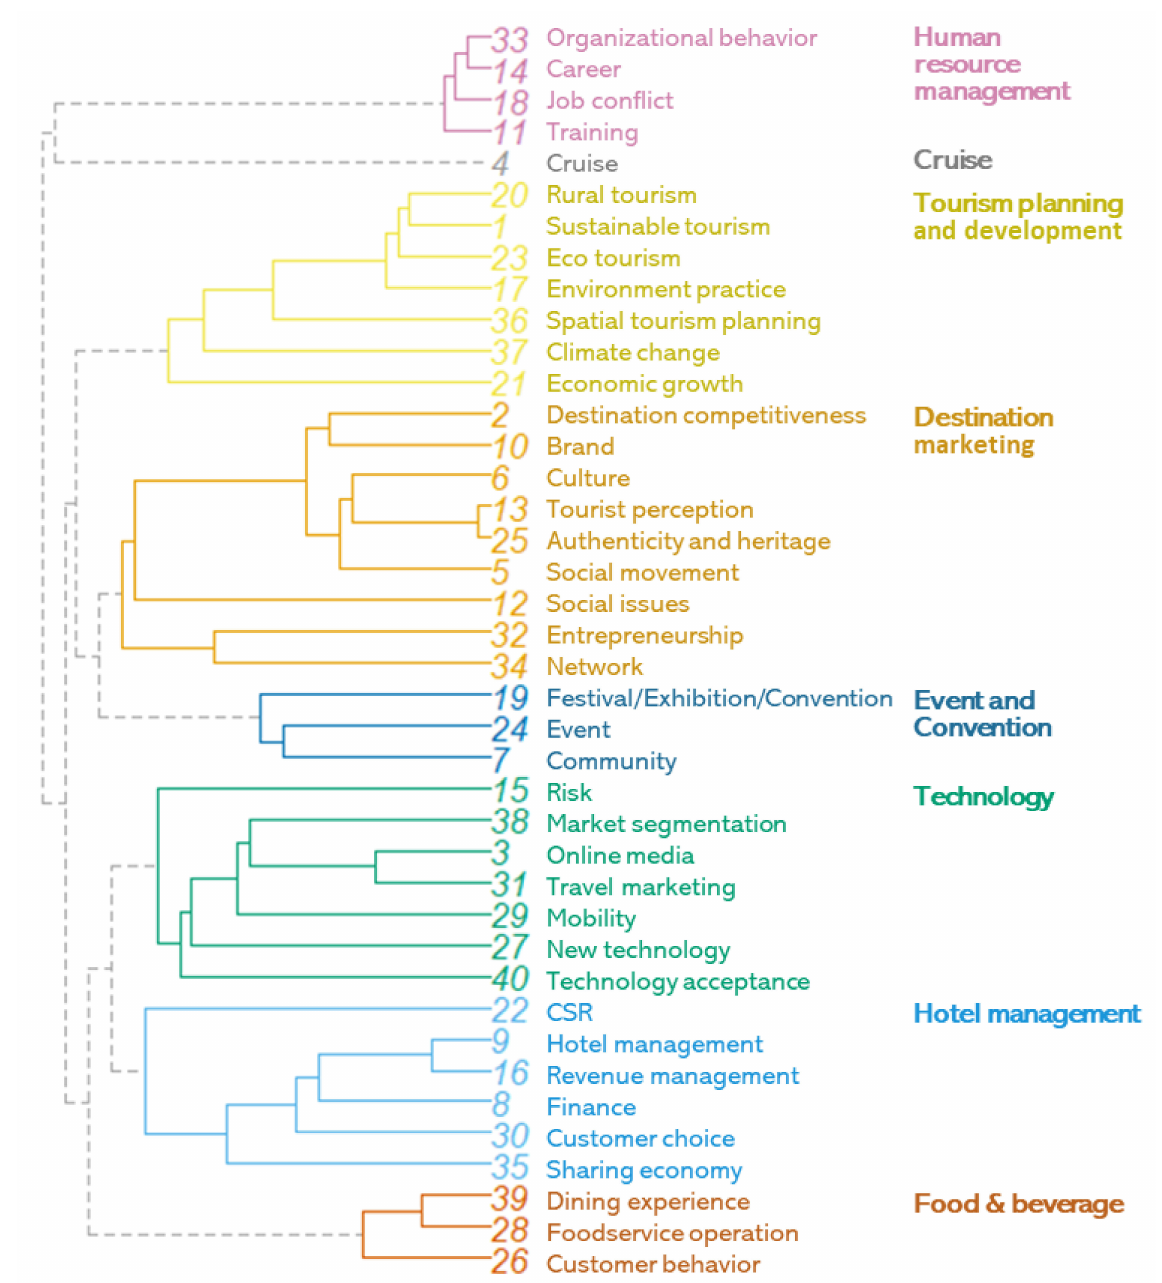
Figure 2. Dendrogram of research topic hierarchical